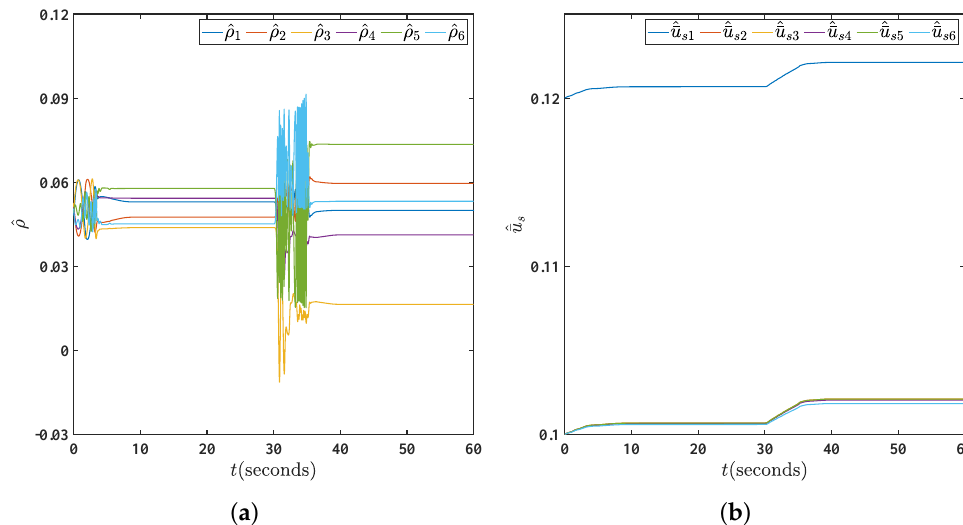
Figure 6. ( a ) Responses of parameter ˆ ρ ( t ) using the proposed methodology in fault case with ρ 3 = 0, σ 3 = 1, ρ 5 = 0.6. ( b ) Responses of parameter ˆ¯ u s ( t ) using the proposed methodology in fault case with ρ 3 = 0, σ 3 = 1, ρ 5 = 0.6.